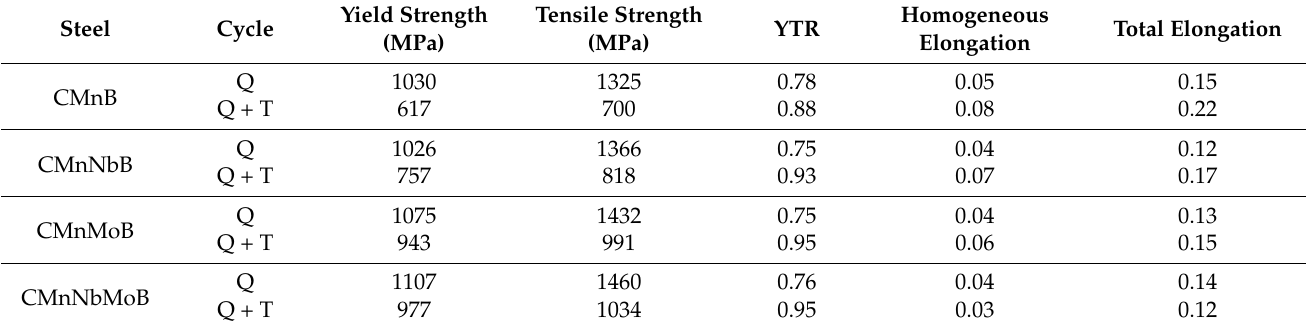
Figure 10. Tensile curves in Q and Q + T cycles for all steel grades.